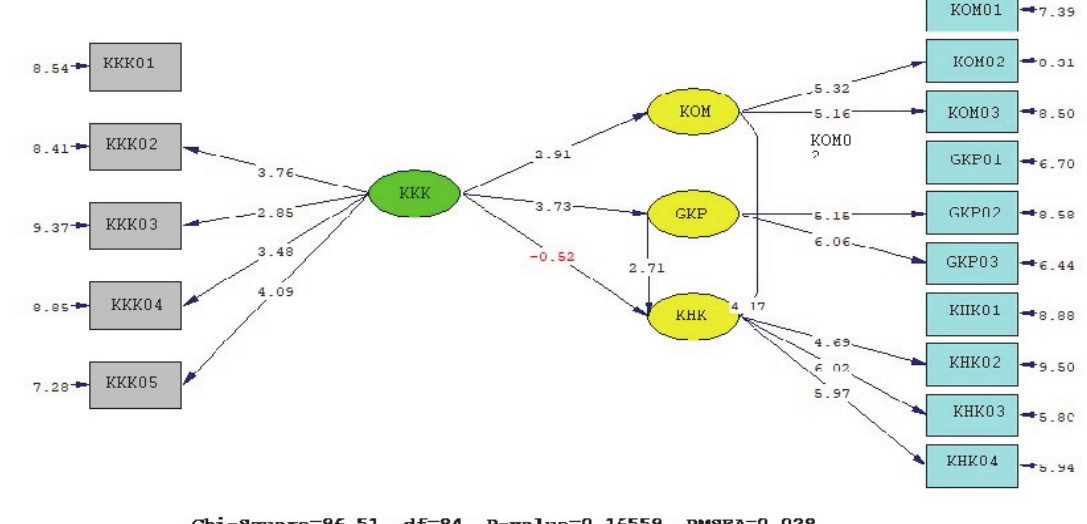
Fig. 2. The results of the statistical